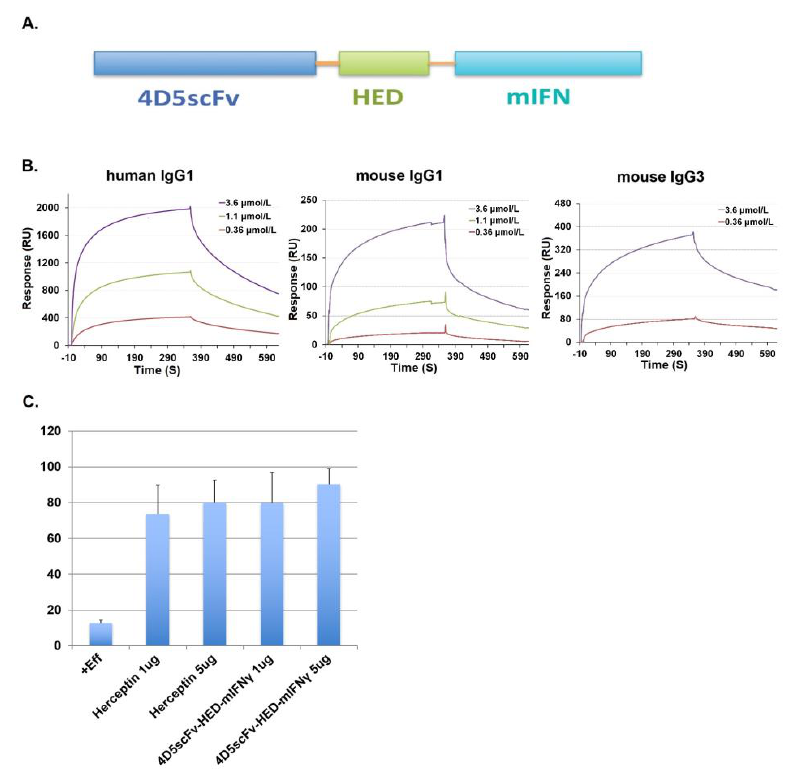
Figure 4. The function of 4D5scFv-HED-mIFN- γ . ( A ) 4D5scFv-HED-mIFN- γ was constructed by sequentially linking the single chain variable fragment of mAb4D5, the HED domain, and mouse interferon gamma together using a general linker of GGGGS. ( B ) Real-time surface plasmon resonance sensorgrams obtained after injection of the purified 4D5scFv-HED-mIFN- γ at different concentrations over sensor chip flow-cell surfaces containing human IgG1, mouse IgG1, and mouse IgG3. ( C ) ADCC activity of human NK cells against breast cancer BT474 cells was tested in the presence of Herceptin or 4D5scFv - HED - mIFN - γ at different concentrations. 4D5scFv - HED - mIFN - γ shows comparable ADCC activity with Herceptin.